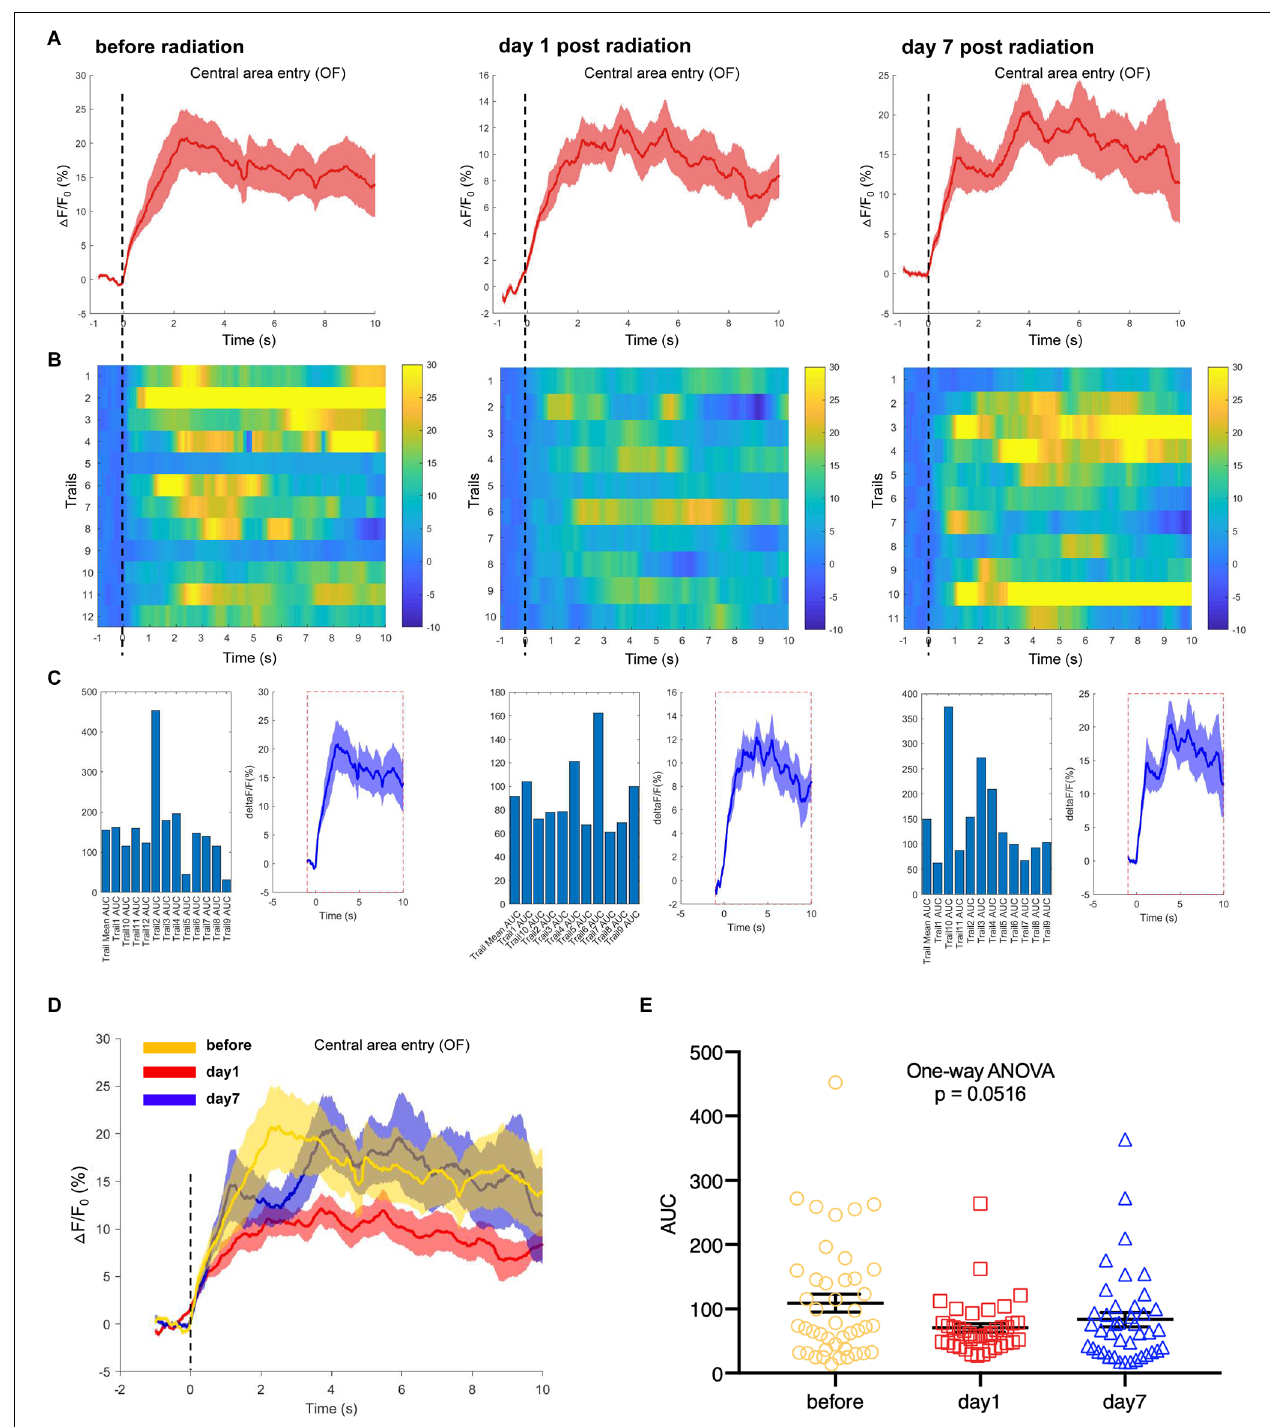
FIGURE 6 | EMP exposure inhibits neuron activities in the hippocampal CA1 area when mice entered the central area in an open field (OF, n = 3 mice). (A) Plot of calcium amplitude (cid:52) F/F 0 (%) of hippocampal CA1 area, before radiation and on day 1 and day 7 after radiation. The red line is the mean of different trials from a single mouse, and the shaded part represents the standard error. (B) Color-coded intensity of calcium transients from different trials, corresponding to each signal presented in (A) . (C) The area under the curve (AUC) between cue onset (0 s) and subsequent 10 s from different trials as shown in (B) . (D) The combined line diagram of calcium amplitude (cid:52) F/F 0 (%) in CA1 neurons as shown in (A) . (E) Plot of AUC in multiple trials from three biological replicates before and different time points after exposure. 0 s for (cid:52) F/F 0 , marked by dotted lines, indicated that mice were entering the central area of OF. The data in (A–E) are presented as mean ± SEM. One-way ANOVA followed by Bonferroni’s post-hoc tests were performed to evaluate the differences between multiple groups in (E) .